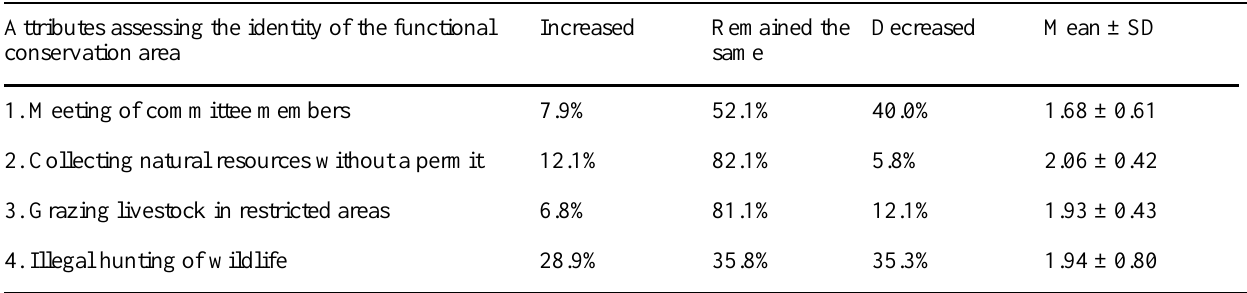
Table 4 . Summary results of the four indicators used to measure the changes in the identity of the conservation institution. Conservation Area Management Committee members were asked if the following activities increased, decreased, or remained the same during the insurgency. The members rated each statement on a 3-point scale: increased = 3, remained the same = 2, decreased = 1. (Source: authors’ interview data; n =